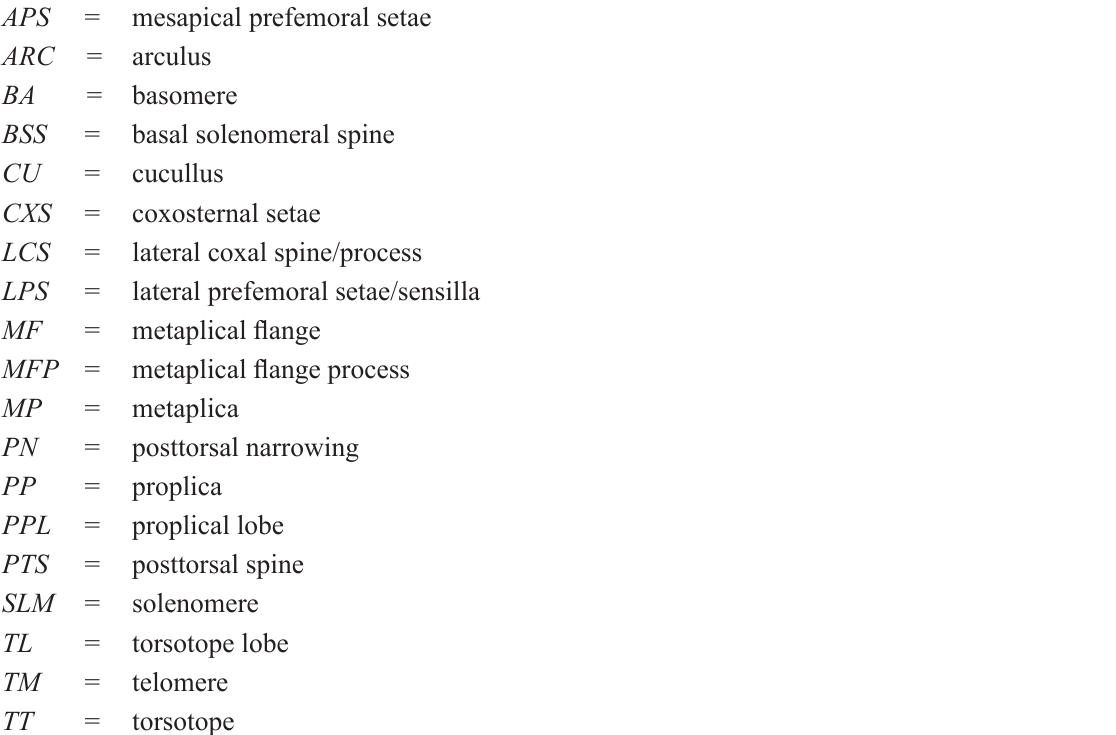
Table 2. Abbreviations for morphological terms used in descriptions and on illustrations of gonopods and first pairs of legs. The table only includes terms for structures which are supposed to be homologous across the family; these abbreviations are in UPPER CASE letters. Additional ad hoc terms are given in lower case letters and are explained in the figure